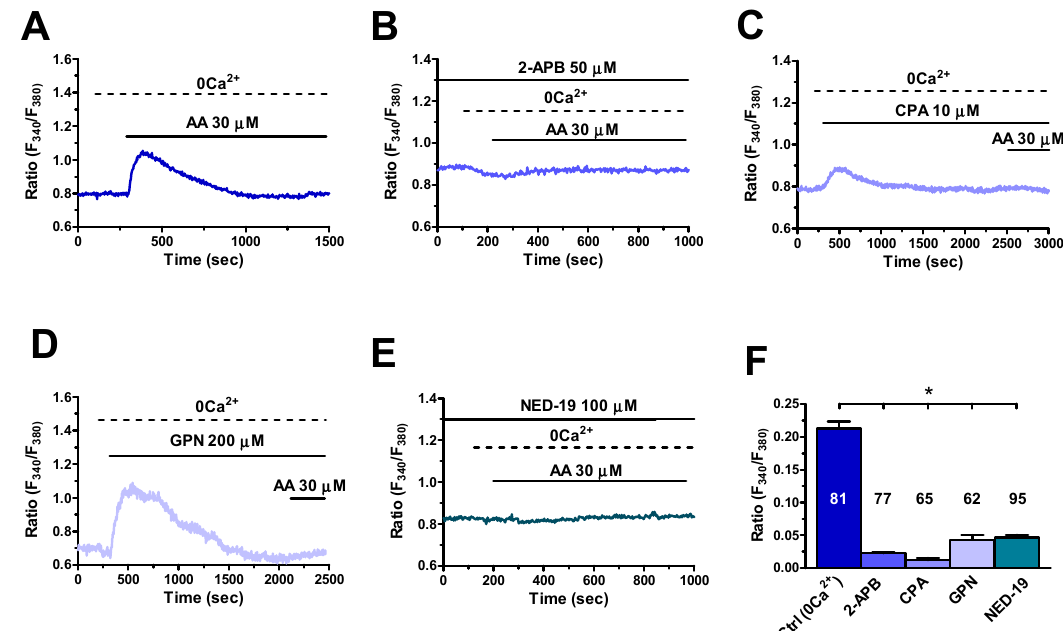
Figure 4. Type 3 inositol-1,4,5-trisphosphate receptor 3 InsP 3 R3 and two-pore channels 1 and 2 (TPC1-2) mediate endogenous Ca 2 + release in response to arachidonic acid in hCMEC / D3 cells. ( A ) Endogenous Ca 2 + mobilization induced by AA (30 µ M) under 0Ca 2 + conditions. ( B ) 2-aminoethoxydiphenyl borate (2-APB; 50 µ M, 30 min) prevents AA-evoked endogenous Ca 2 + release. In this and in the following panels, AA has always been applied at 30 µ M. ( C ) Cyclopiazonic acid (CPA; 10 µ M) inhibited Sarco-Endoplasmic Reticulum Ca 2 + -ATPase (SERCA) activity, thereby eliciting a transient elevation in [Ca 2 + ] i followed by Ca 2 + removal from the cytosol. The following addition of AA did not result in an increase in [Ca 2 + ] i . ( D ) Glycyl-L-phenylalanine 2-naphthylamide (GPN; 200 µ M) elicited a transient elevation in [Ca 2 + ] i due to the disruption of the lysosomal Ca 2 + pool and the following liberation of lysosomal Ca 2 + content into the cytosol [41,42]. The following addition of AA did not result in an increase in [Ca 2 + ] i . ( E ) NED-19) (100 µ M, 30 min) blocked AA-evoked intracellular Ca 2 + release. ( F ) Mean ± SE of the amplitude of the intracellular Ca 2 + response to AA under the designated treatments. The asterisk indicates p < 0.05.